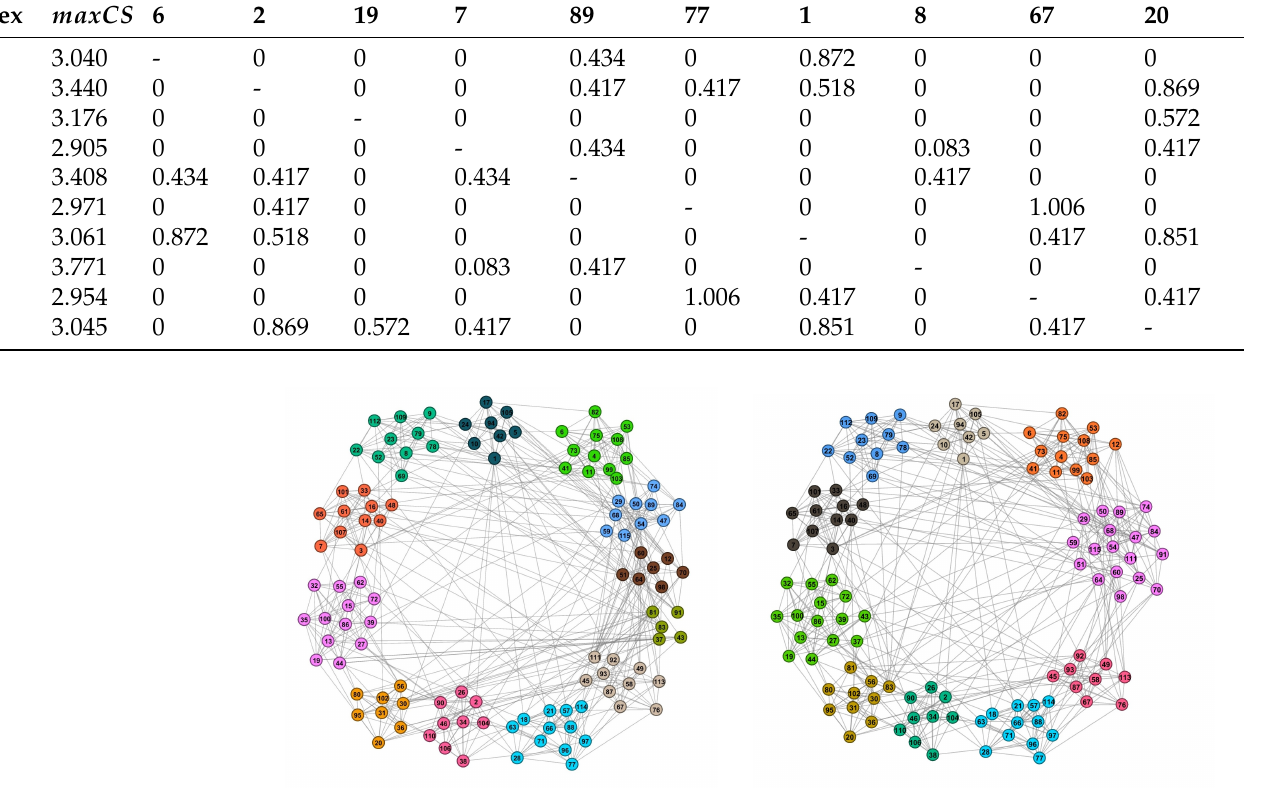
Table 5. Connection strength of community centers on Football network.